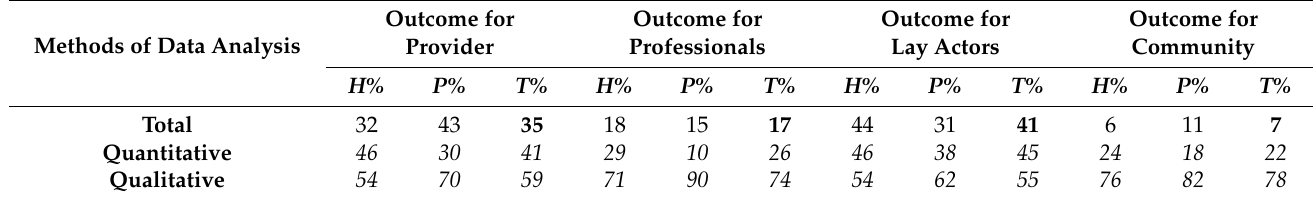
Table 5. Methods for stakeholder outcome